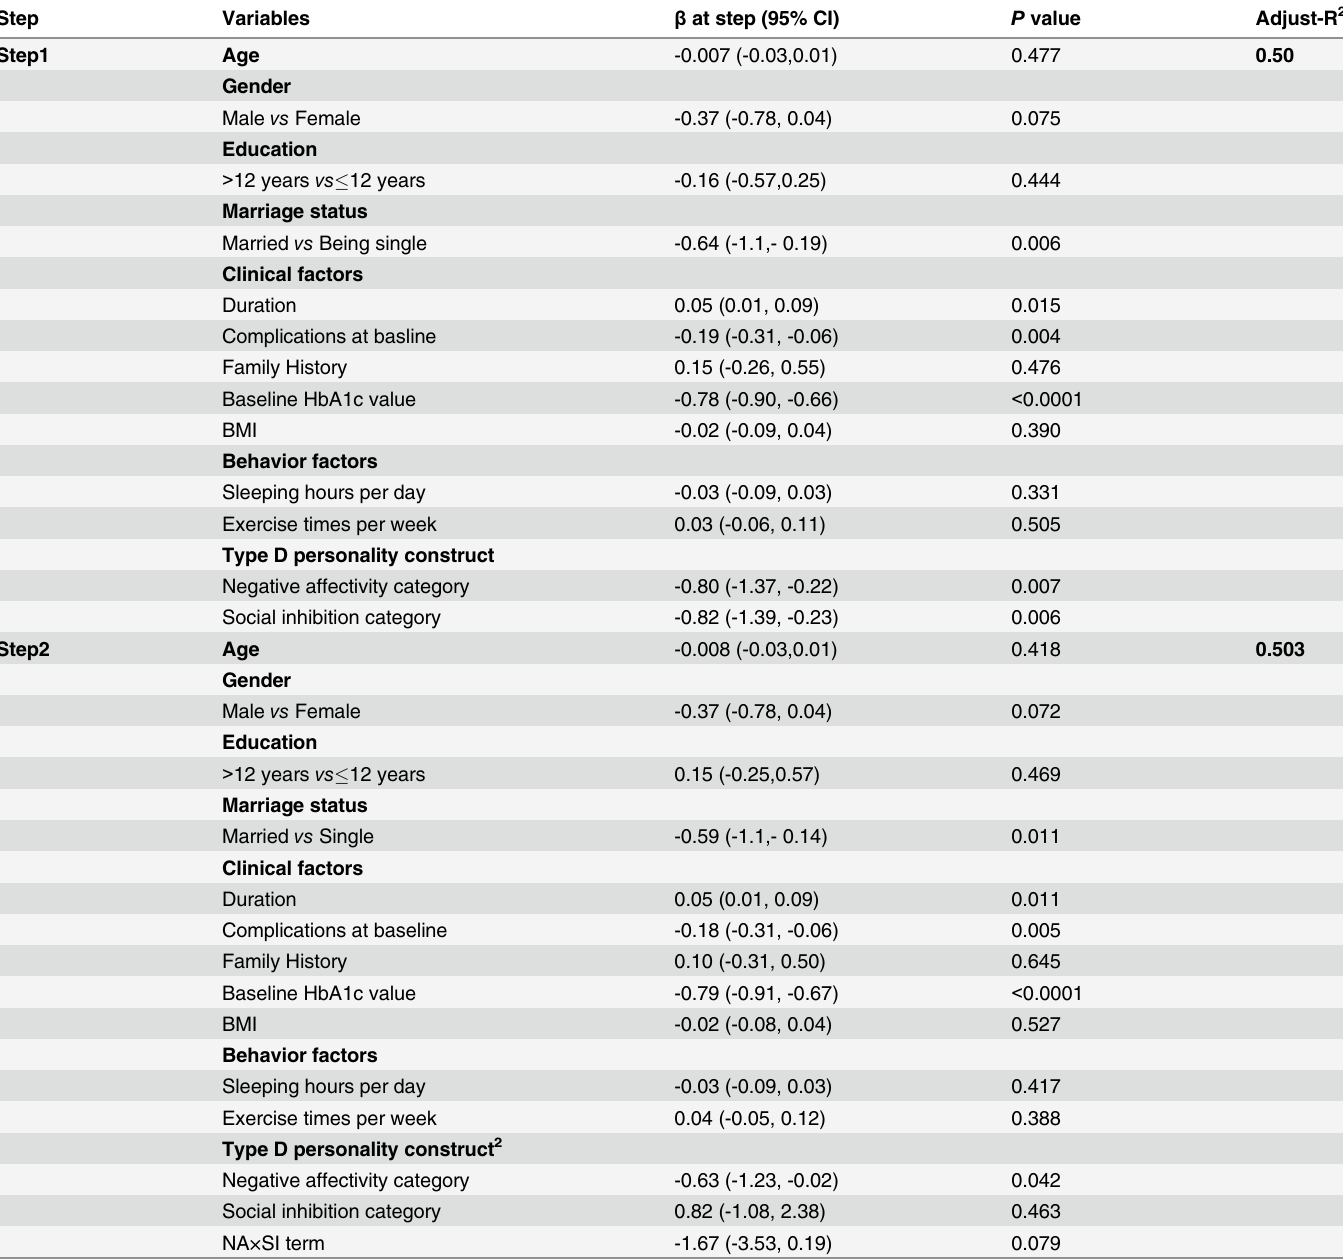
Table 4. Type D persoinality components: NA and SI on medication adherence 1